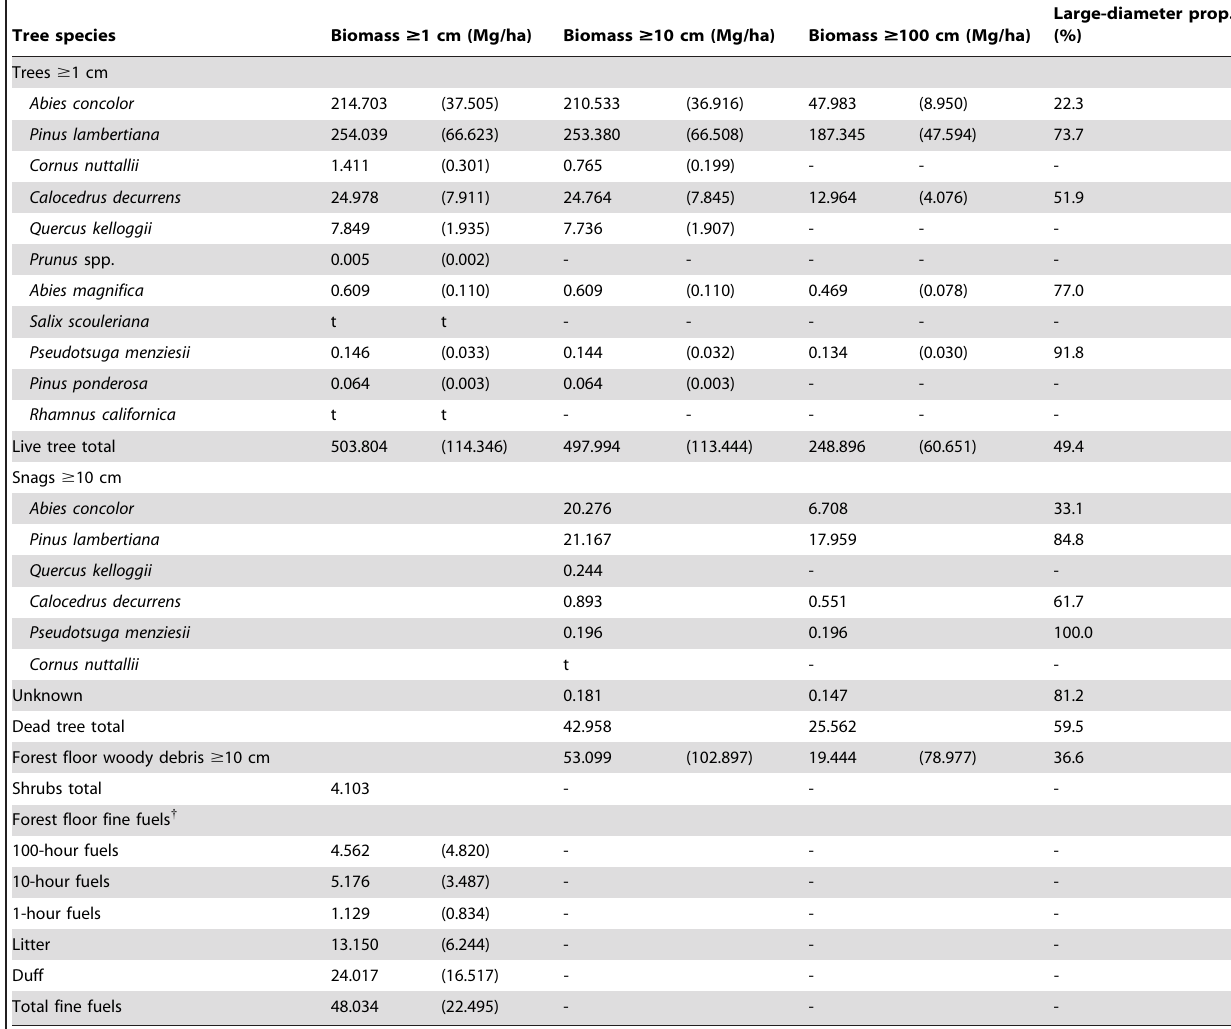
Biomass is shown to three significant figures (corresponding to 1 kg/ha) to facilitate comparison between less abundant, small-diameter species and more abundant species (standard deviation shown in parentheses). Standard deviation of tree biomass was based on the root mean squared error of the underlying